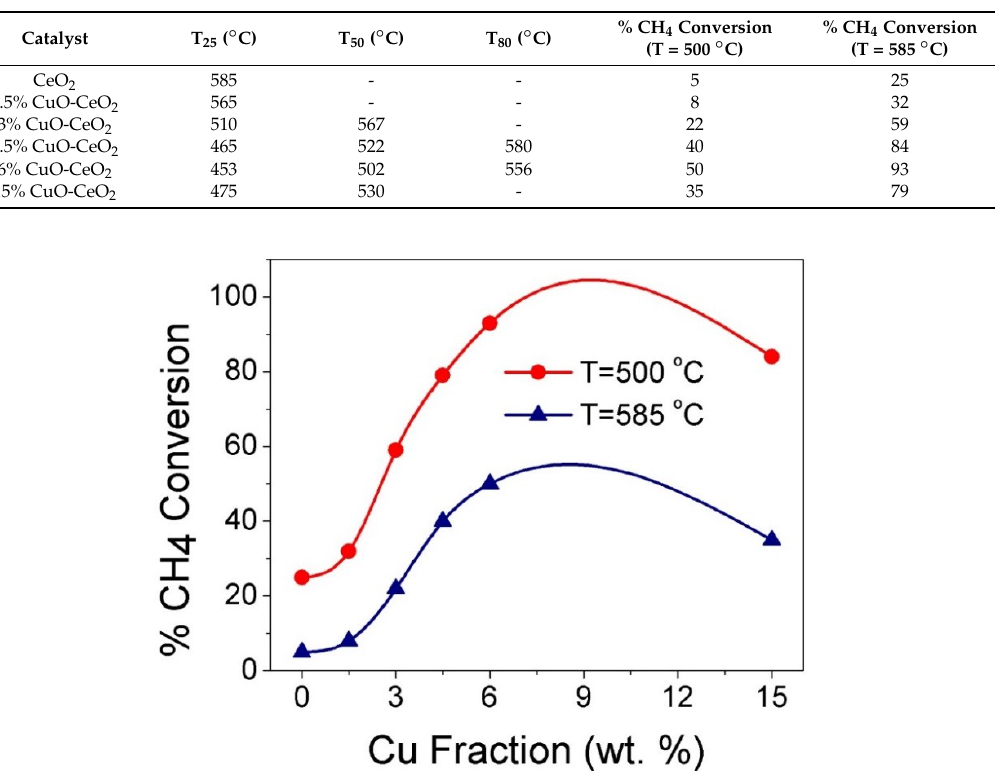
Figure 7. Effect of Cu content (wt.%) on the CH 4 conversion (%) at T = 500 °C and 585 °C for different xCuO-CeO 2 catalysts (x = 0, 1.5, 3, 4.5, 6, 15%) prepared by SCS.